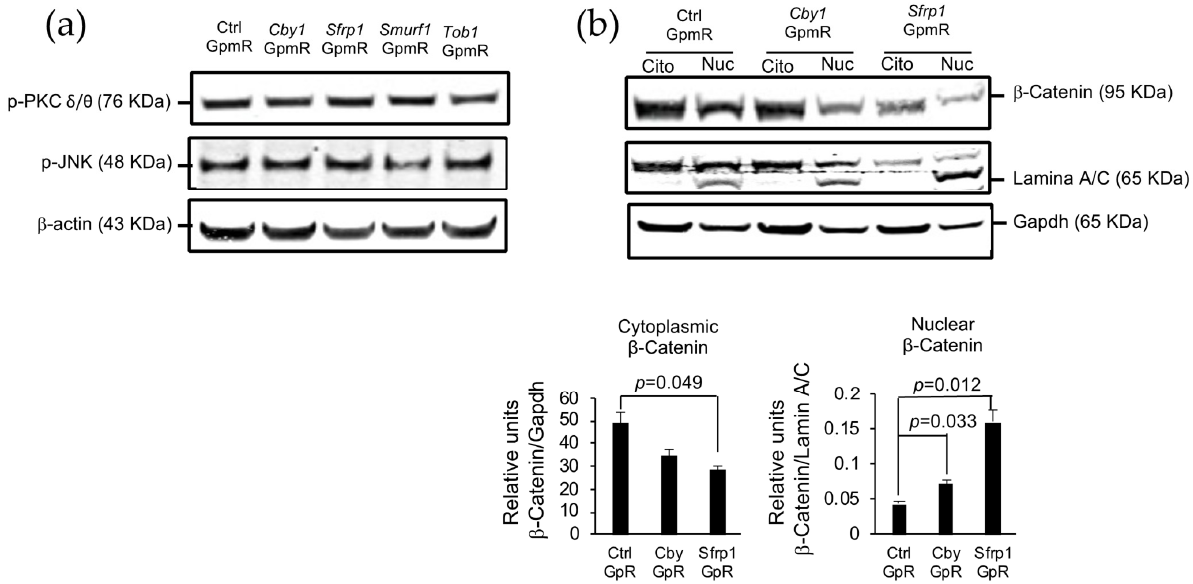
Figure 2. Effect of Cby1 and Sfrp1 silencing on canonical and non-canonical Wnt pathways. Each experiment was performed in duplicates. A representative experiment is shown. ( a ) Western blot of JNK and PKC phosphorylation used as markers of the Wnt/PCP and the Wnt/PKC pathway activation. Forty-eight hours after transfection with the different GapmeRs, osteogenic media was added for an additional 48 h before whole protein extracts were obtained. β -actin was used as a loading control. ( b ) Presence of the nuclear and cytoplasmic β -catenin was quantified in nuclear and cytoplasmic cell extracts. Lamin A/C and Gapdh were used for normalization of the nuclear and cytoplasmic signals, respectively.